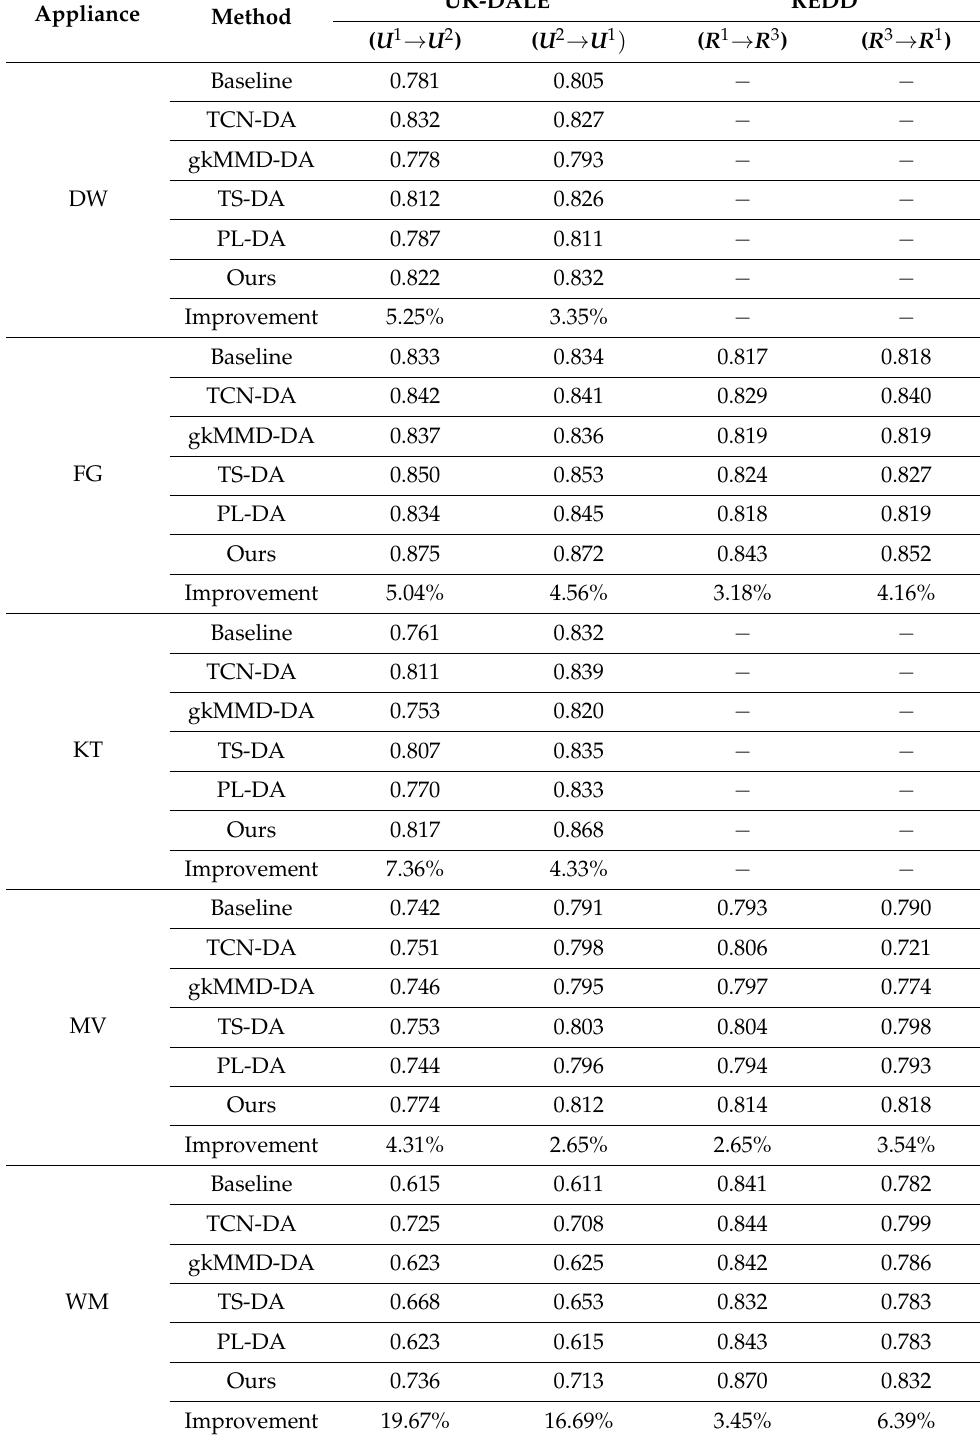
Table 3. F1 score comparison of domain adaptation within the same